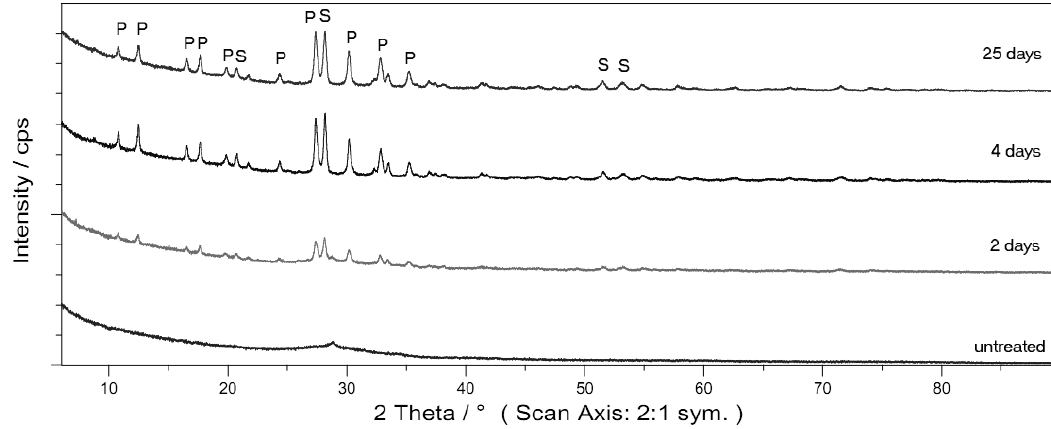
Figure 2. Comparison of the X-ray diffractograms of untreated and hydrothermally treated